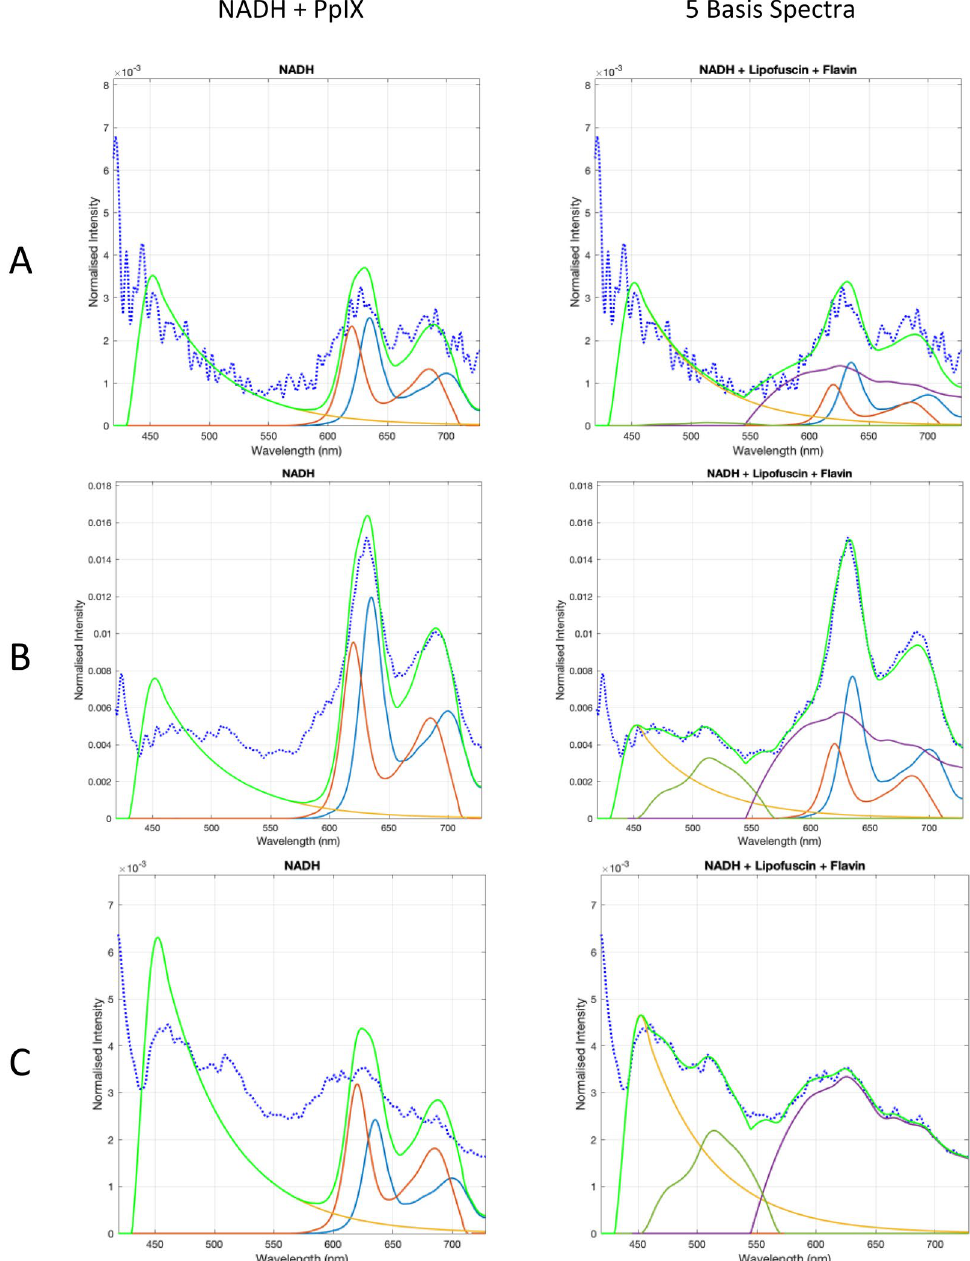
620 , blue: PpIX 634 , purple: lipofuscin, yellow: NADH, green: flavin). The measured spectrum is shown in blue dots, and the fitted curve is bright green. As was the case with all spectra, the fit was better